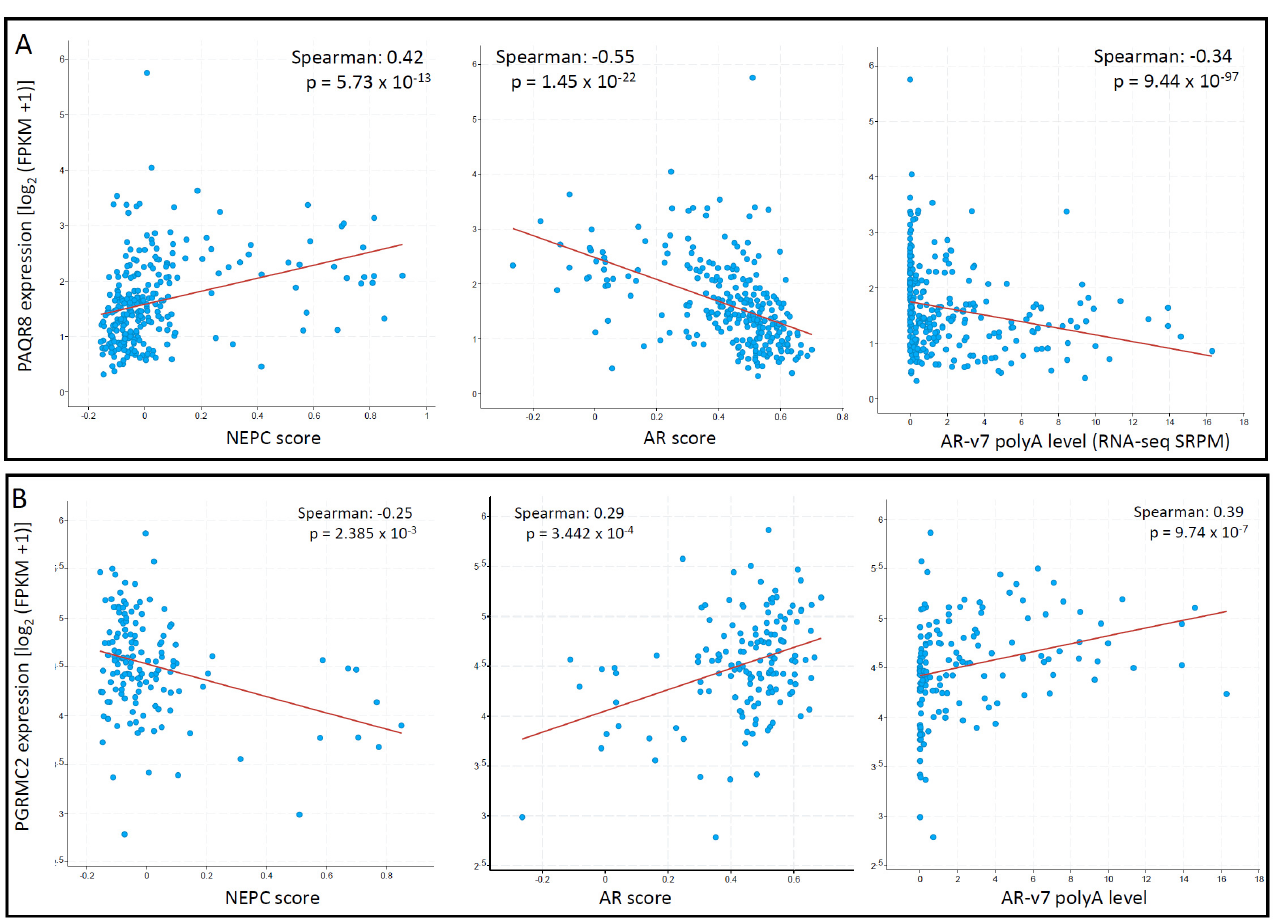
Figure 8. ( A , B ) PAQR8 expression is inversely correlated with NEPC and AR scores in prostate cancers. Spearman correlation coefficient analysis was conducted using the RNA-seq dataset generated from metastatic prostate cancers, as described [26]. The figure images were generated on the cBioportal platform.